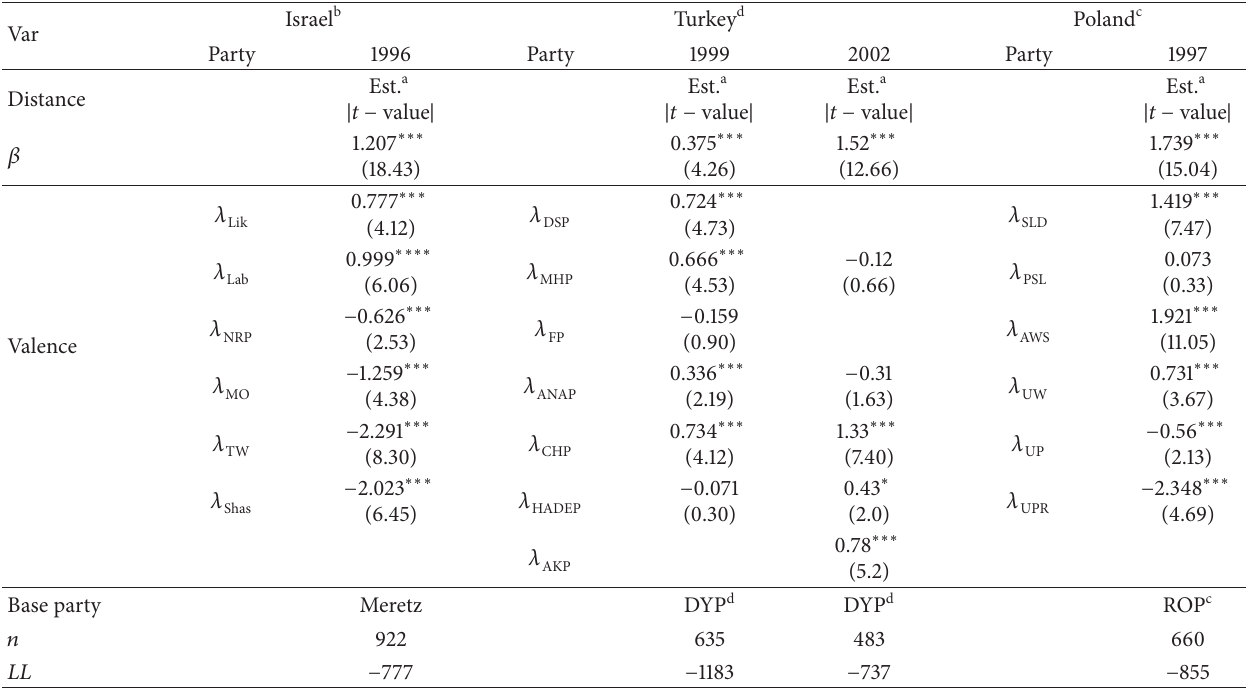
Table 3: MNL spatial model for countries with proportional systems.